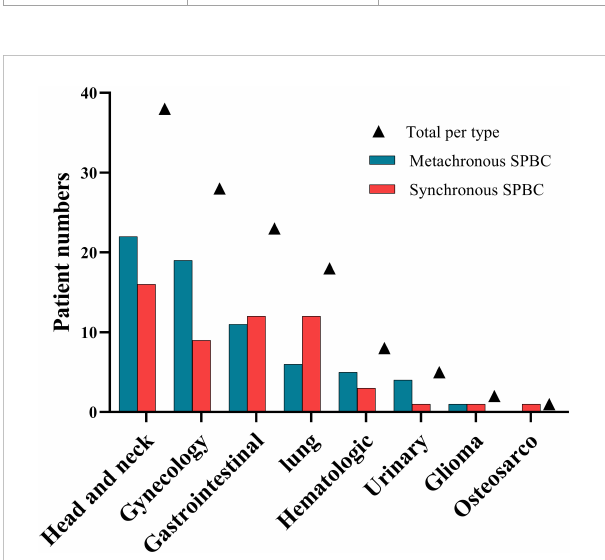
FIGURE 1 Types of primary non-breast malignancy in patients with second primary breast